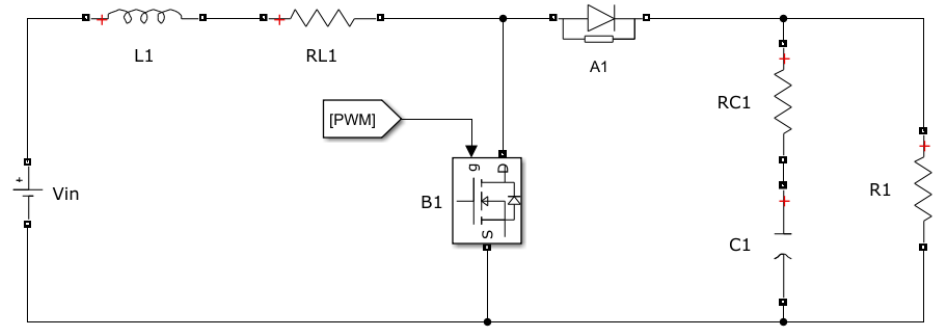
Figure 9. Simulink/Simscape model of the boost converter.